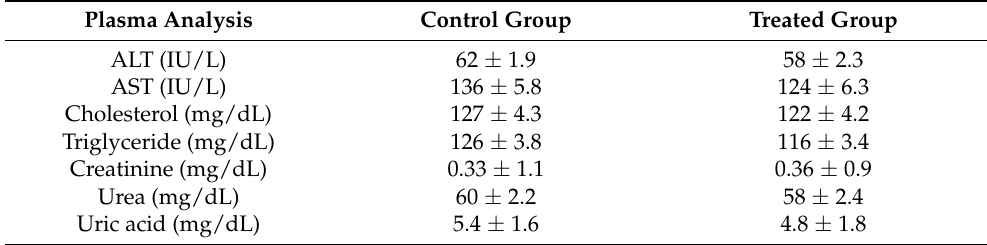
Table 7. Biochemical analysis of control and TRHC-PAG-alginate microspheres treated group.